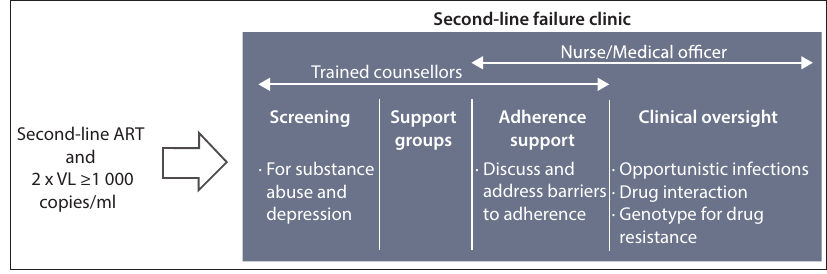
Fig. 1. Key elements of the second-line ART failure clinic. (VL = viral